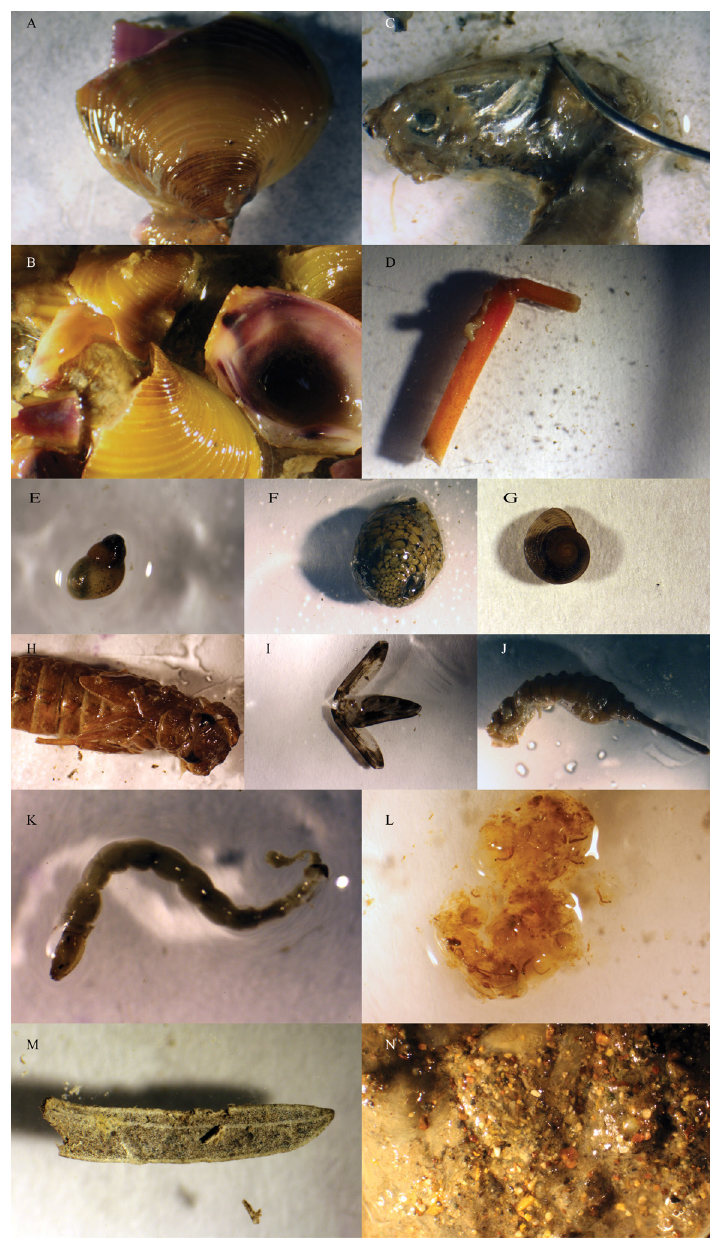
FIGURE 4 | Examples of prey items identified in each category. Fish were caught in each river and taken back to the lab to be dissected. Stomach contents were removed and prey items were identified under a dissection microscope. A and B are examples of bivalves, likely belonging to Polymesoda. C was a fish, could not be identified any further than that. D is a leg from a crustacean, likely a shrimp. E , F and G are all examples of gastropods. H , I , and J are from the insect category. K and L are from the category invert others while M is an example of plant material. N is an example of unidentifiable matter which is also possibly consumed